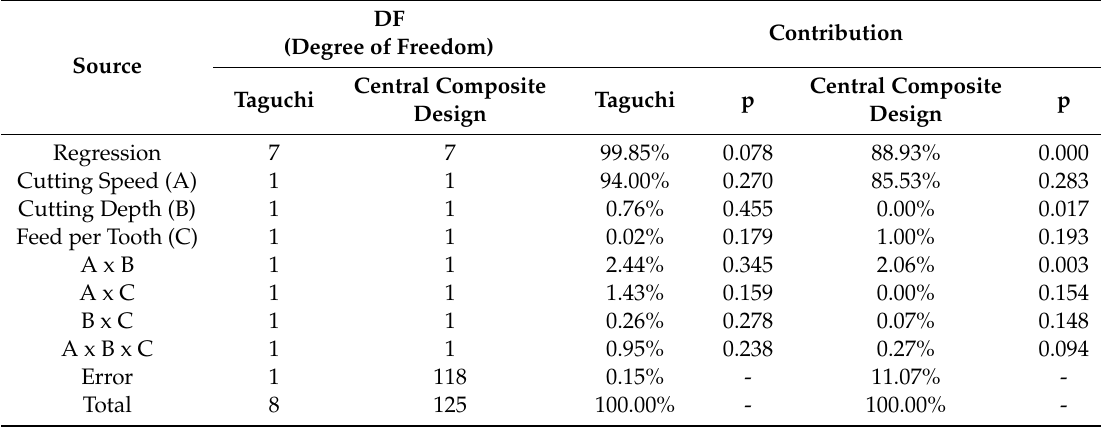
Table 9. The variance analysis (Taguchi (cid:48) s method and central composite design).